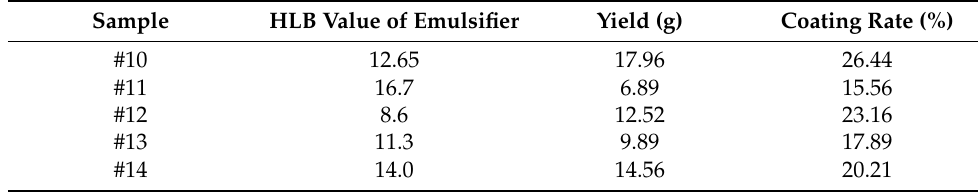
Table 8. Results of yield and coating rate in single factor test.